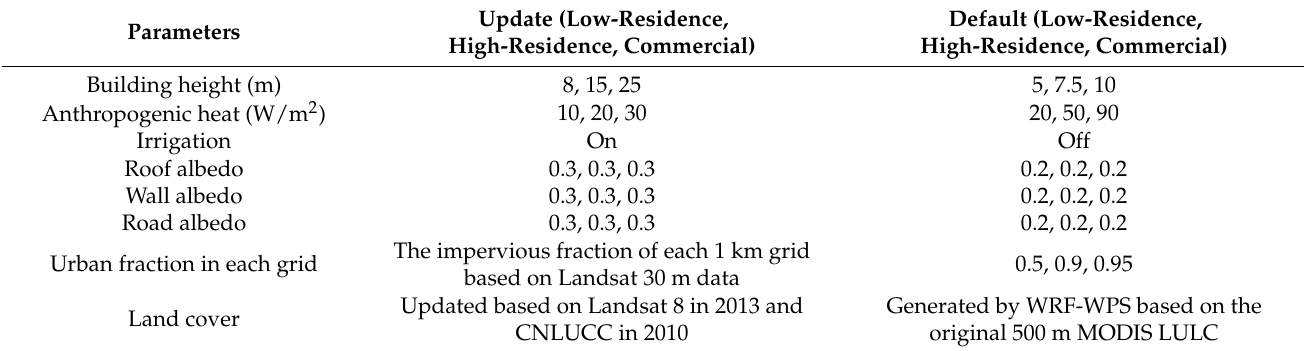
Table 2. The comparison of parameters in the update and